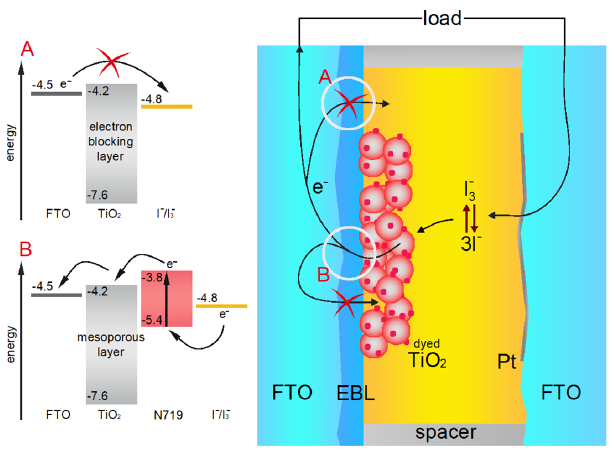
Figure 1. Schematic representation of the fabricated dye-sensitized solar cell (DSSC) devices with an additional electron blocking layer (EBL). As presented in diagram A , the EBL prevents electrons from being injected back from the photoanode to the redox electrolyte, according to the reaction 2(cid:1857) – + (cid:1835) (cid:2871)– → 3I – . The generation of photocurrent is presented in diagram B .